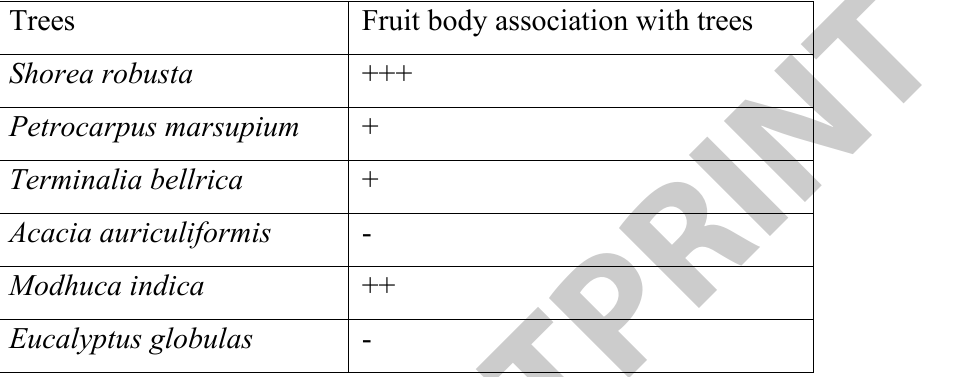
Note: - indicates no association or mushroom fruit body, + indicates presence of a lower number of mushroom fruit bodies or association, ++ indicates a moderate number of fruit bodies, and +++ indicates an abundance of mushroom fruiting bodies.